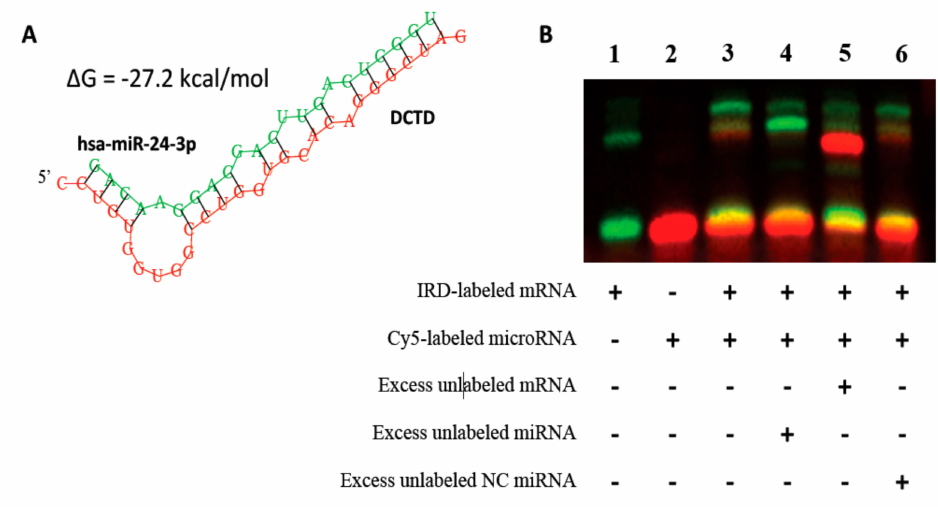
Figure 4. Validation of binding interaction between DCTD mRNA and has-miR-24-3p by RNA electrophoretic mobility shift assays (EMSAs). RNA EMSA with cy5-labeled has-miR-24-3p oligonucleotide and 2’-O-methyl modified and IRD-800 labeled DCTC mRNA oligonucleotide. Lanes 1 and 2 show the mobility of the labeled mRNA or miRNA oligonucleotide. Lane 3 shows the mobility of the labeled has-miR-24-3p oligonucleotide with DCTD mRNA oligonucleotide. Lanes 4 and 6 show the mobility of labeled DCTD mRNA oligonucleotide in presence of unlabeled excess specific competitor (has-miR-24-3p) ad excess unlabeled non-specific competitor